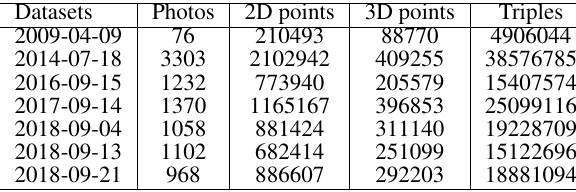
Table 1: The distribution of photographs, 2D/3D points and total number of triples for each of Xlendi temporal datasets Similar to the artifact dataset, seven SPARQL user interfaces, allowing to query temporal datasets, are made accessible online